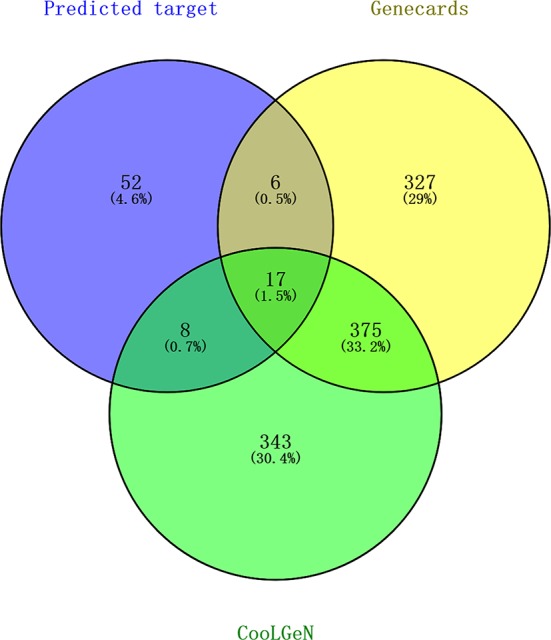
Screening of targets for the identified components of GXNT on thrombus. 83 Predicted targets (in the blue circle) were mapped to 743 thrombus-related targets in CooLGeN (in the green circle), and to 725 thrombus-related targets in the GeneCards database (in the yellow circle), respectively. Among them, 23 targets were found in the GeneCards database, and 25 targets were found in the CooLGeN database. The intersection of these targets resulted in a total of 17 potential antithrombotic targets of GXNT.